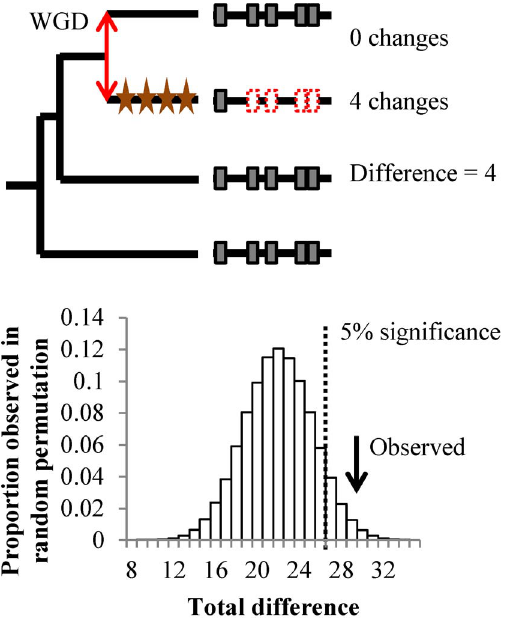
Fig. 3. Correlated evolution of short linear motifs. Top panel shows the procedure to obtain the number of lineage specific changes in constraints in a single protein. Red double arrow illustrates the duplication event. Stars represent significant changes in constraints along the lineage. Significant changes in constraints detected on short linear motifs are shown in dotted red boxes. Bottom panel shows the distribution of the total cumulated number of lineage specific changes in constraints from a non-parametric permutation test. Arrow shows the observed total difference for all 20 paralog pairs.